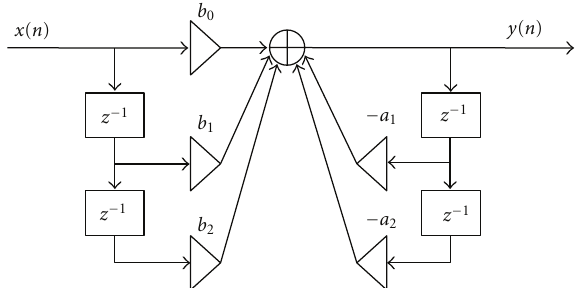
Figure 11: Direct form I implementation of a biquad IIR filter.